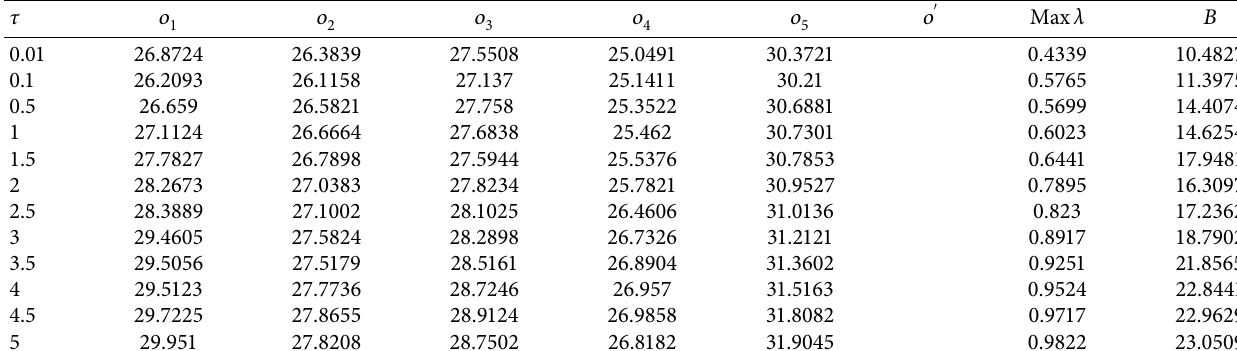
Table 3: Scenario 1: model optimal solution with diferent covariance